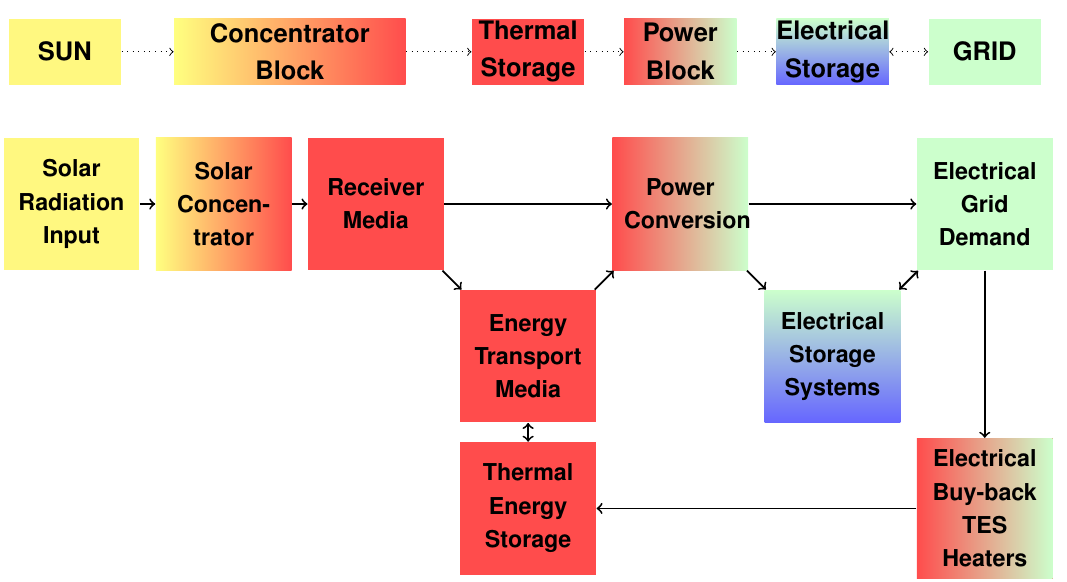
Figure 1. General Overview of Energy Conversion Blocks for Concentrated Solar Power, adapted